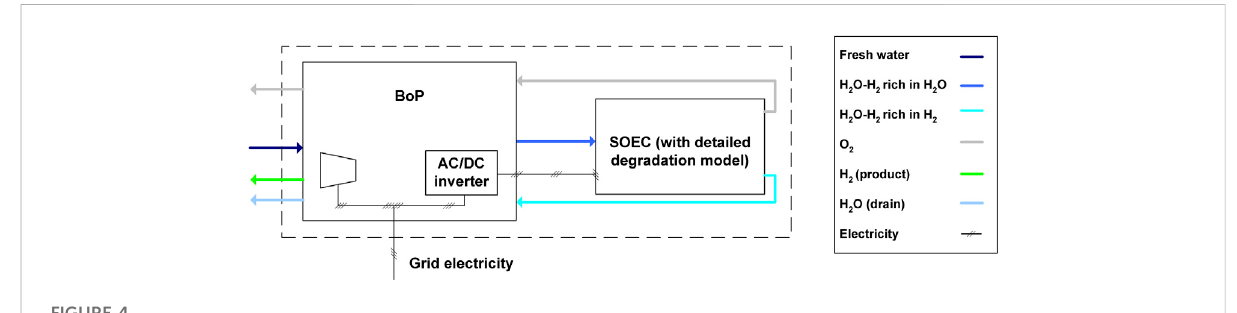
FIGURE 4 An outline of the SOEC